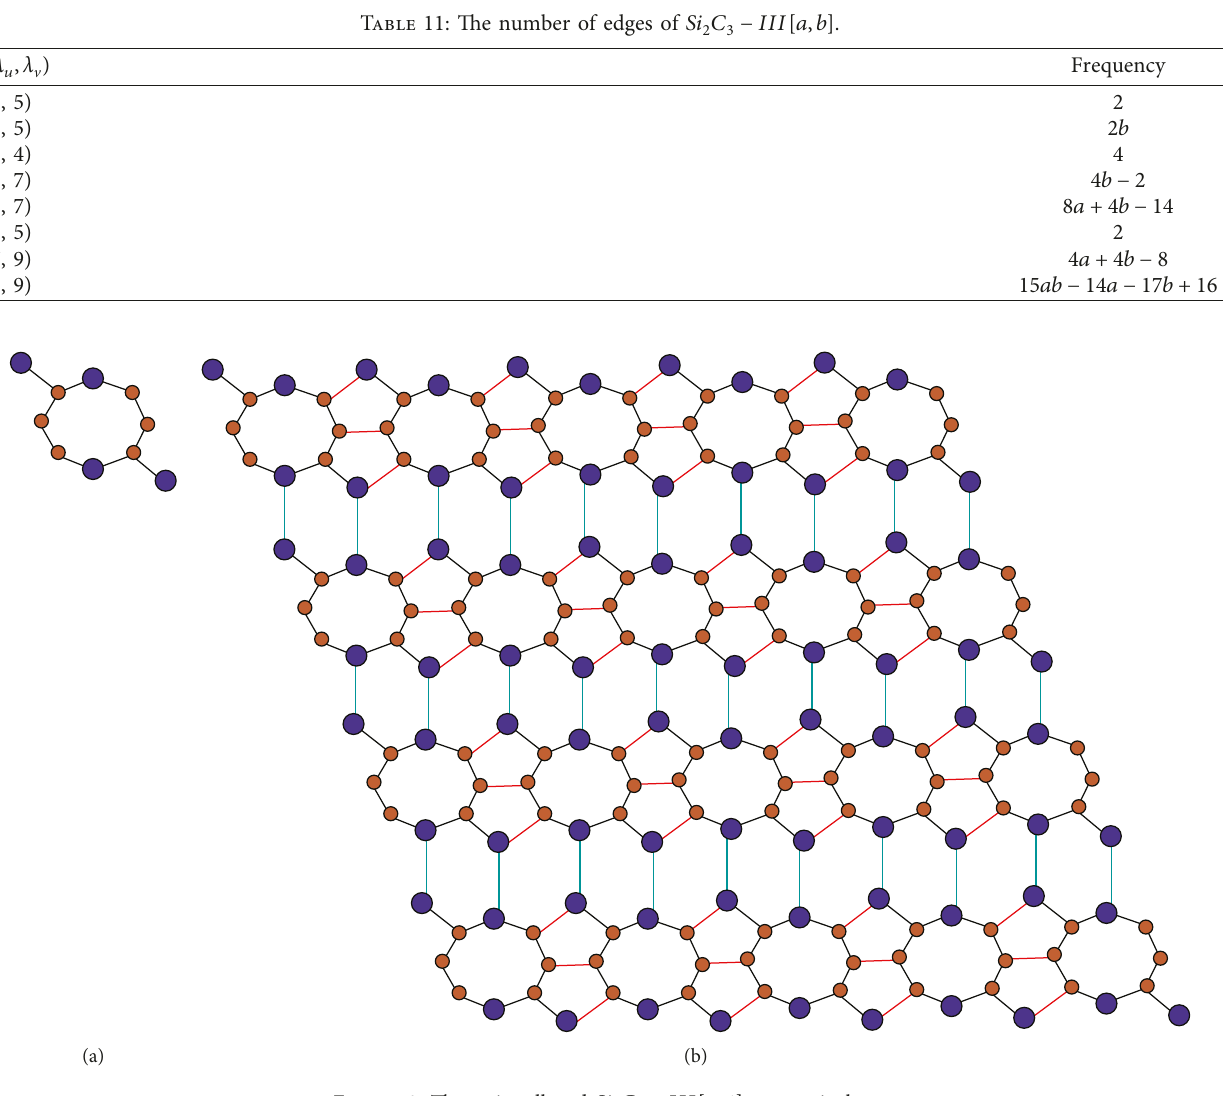
Figure 8: The unit cell and Si